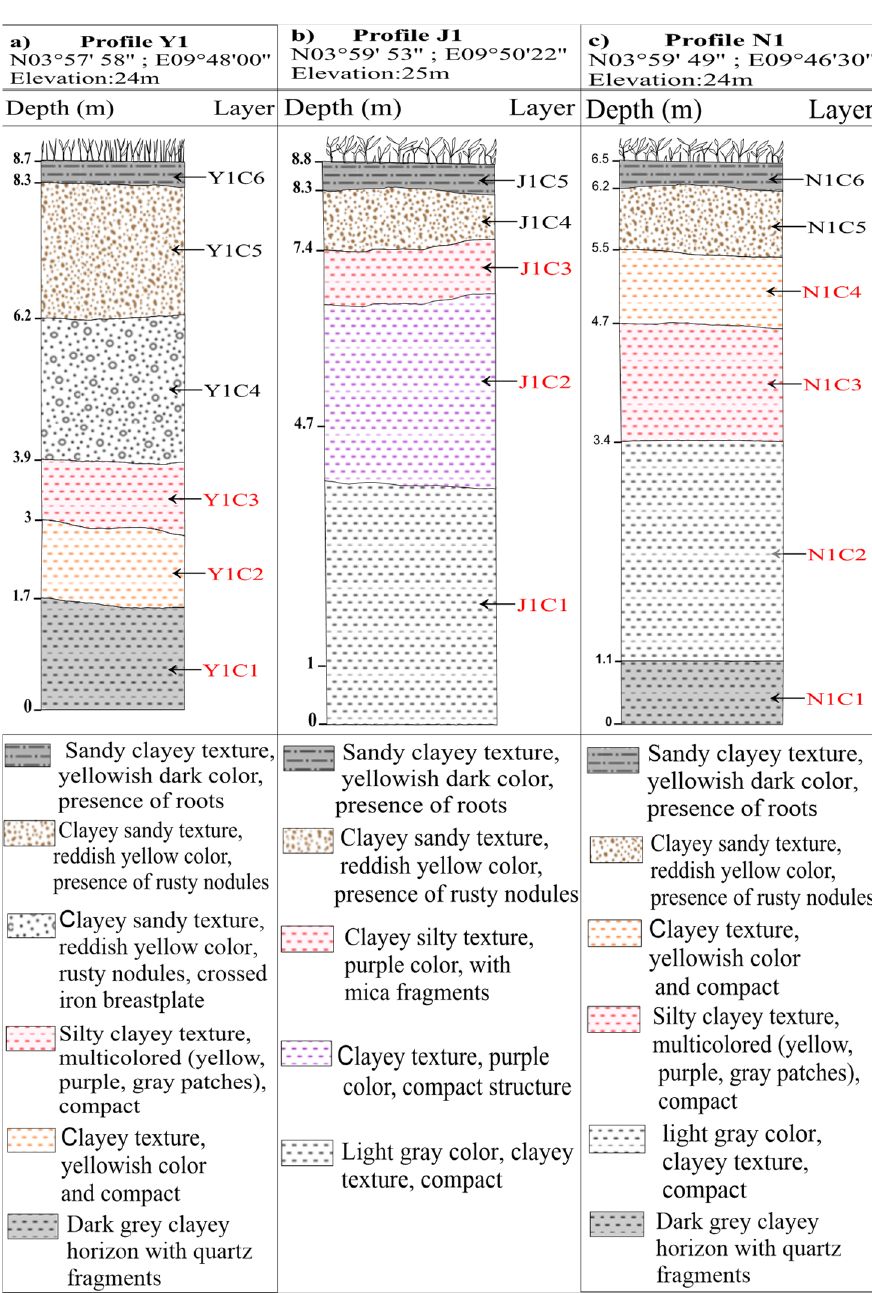
Figure 2. Morphology of profiles of the clayey materials of the eastern part of the Douala sub-basin. ( a ) Profile Y1 of Yansoki with analyzed samples Y1C1, Y1C2, Y1C3; ( b ) Profile J1 of Japoma with analyzed samples J1C1, J1C2, J1C3; ( c ) profile N1 of Ndogpassi with analyzed samples N1C1, N1C2, N1C3, N1C4.